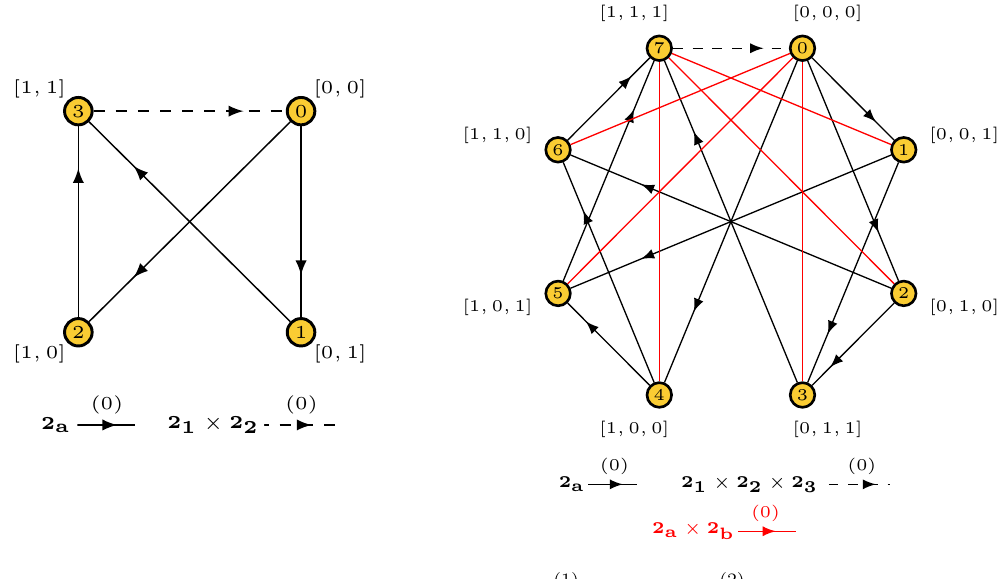
Figure 6. Quiver diagrams for F (1)